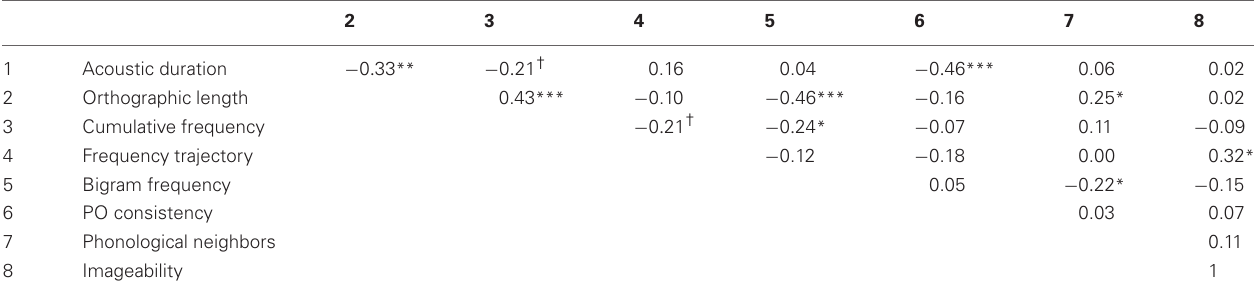
Table 4 | Correlations of the by-subject independent variables’